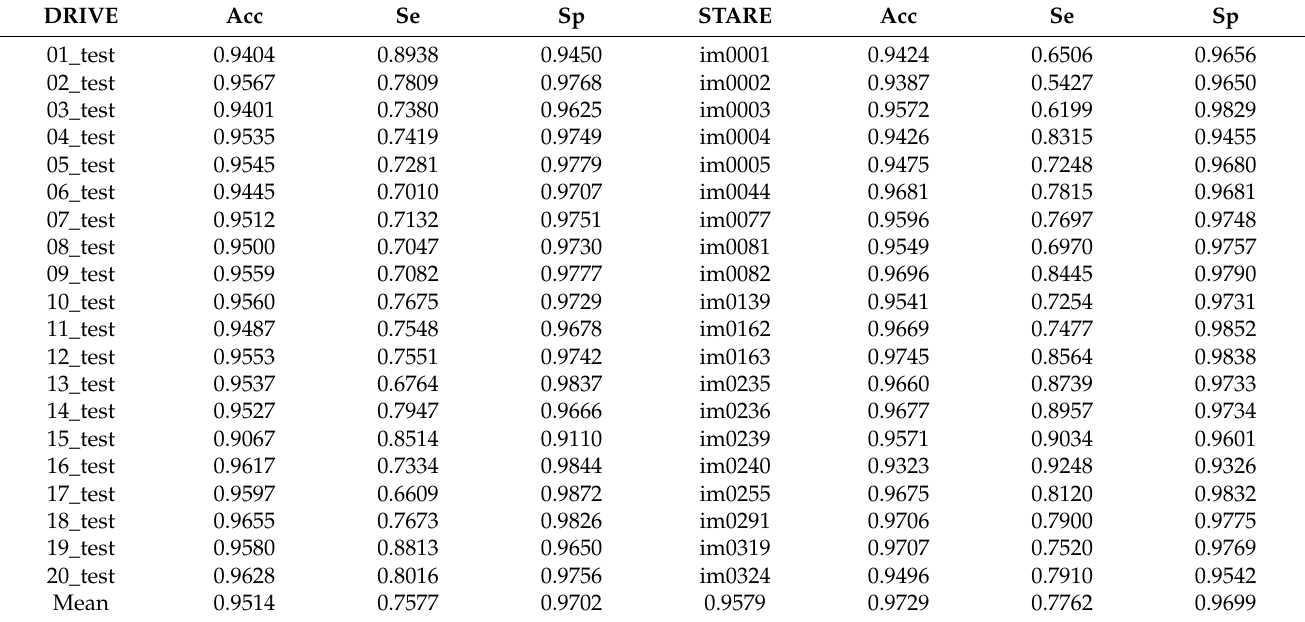
Table 3. Test results of the proposed algorithm on DRIVE dataset and STARE dataset.